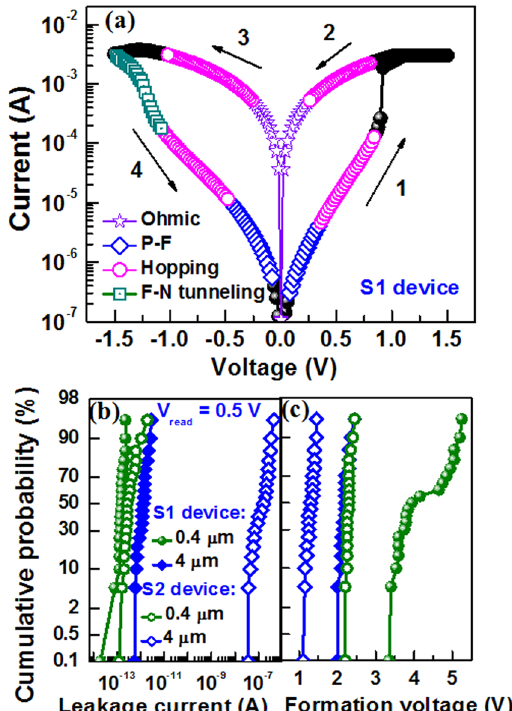
Figure 4. ( a ) Typical bipolar resistive switching characteristics of the S1 devices. Cumulative probability of ( b ) leakage current and ( c ) formation voltage for randomly measured many S1 and S2